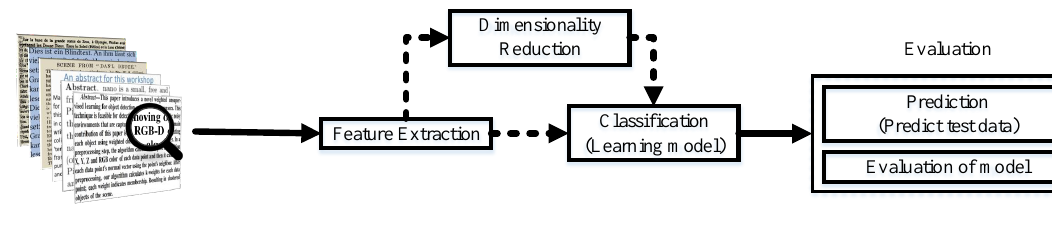
Figure 1. Overview of text classification